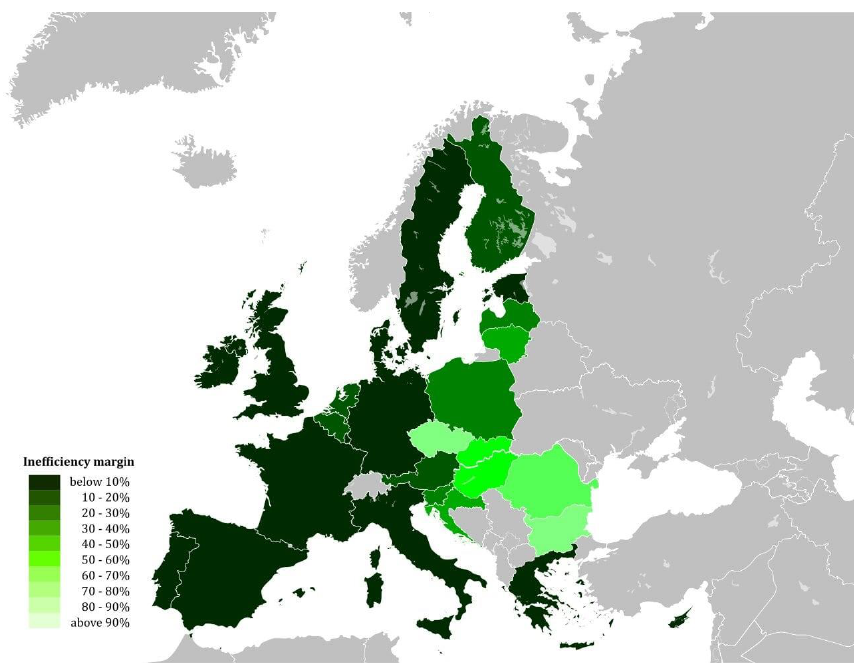
Energies 2021 , 14 , x FOR PEER REVIEW Figure A1. Efficiency scores across countries in 2015 on a map of Europe. Figure A1. Efficiency scores across countries in 2015 on a map of Europe.